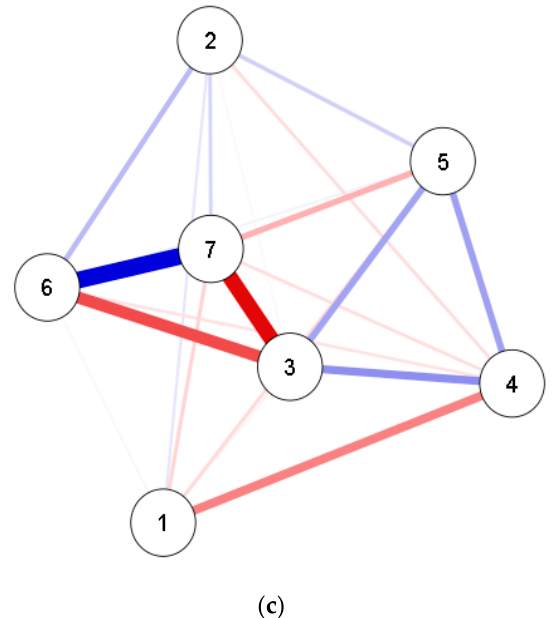
Figure 2. Network associations between movement behaviors, fundamental motor skills (FMS), Body Mass Index (BMI) and sex by age. ( a ) 3 year-olds; ( b ) 4 year-olds; ( c ) 5 year-olds; Positive associations are expressed by the blue color and negative associations by the red color. Thickness of the graph indicates the weight of the ratio. 1—BMI; 2—TPA + MVPA; 3—sleep time; 4—screen time; 5—sex; 6—locomotor skills; 7—ball skills.